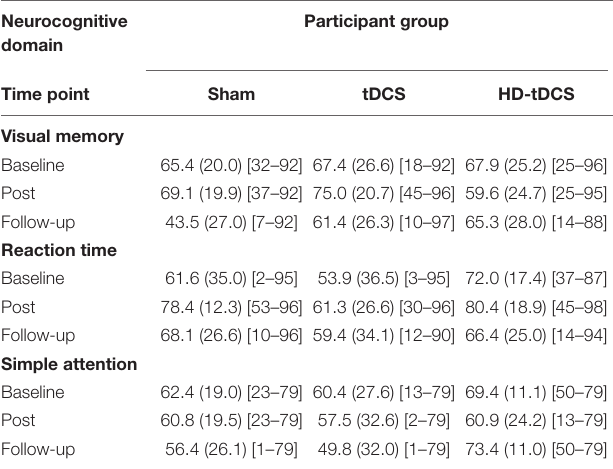
TABLE 2 | Group mean performance on the CNS Vital Signs neurocognitive